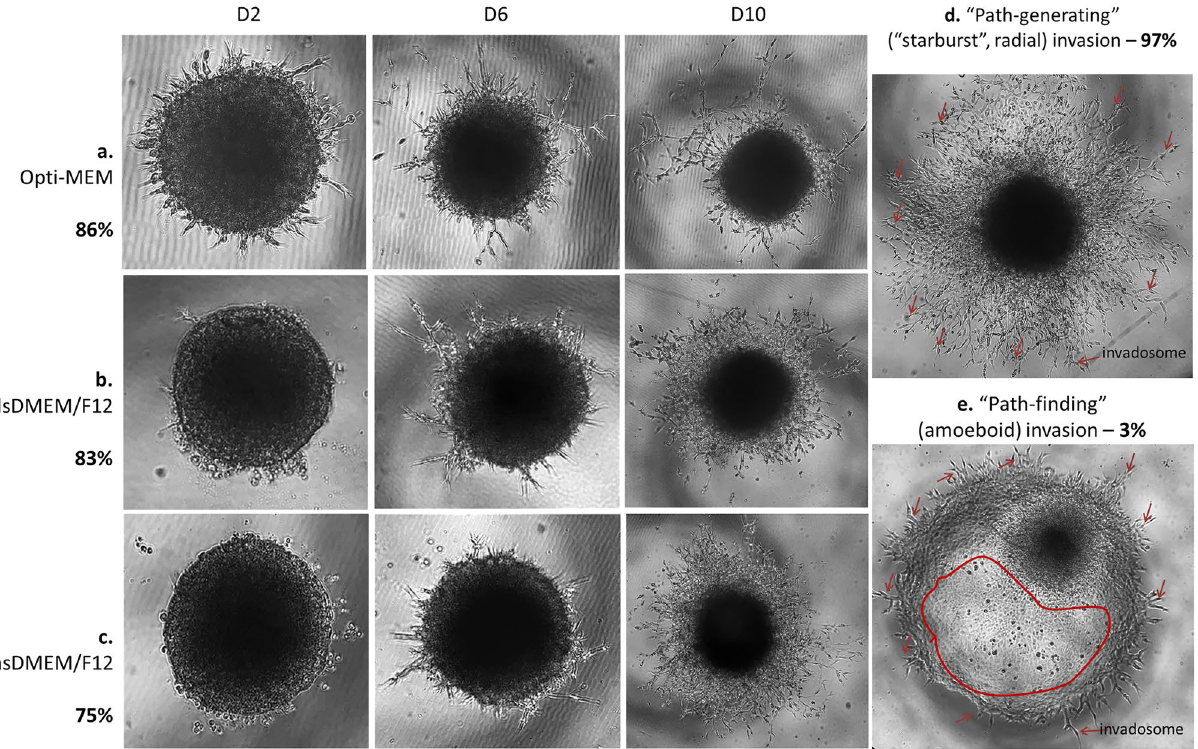
Figure 4. Sw71 spheroids’ propensity for invasion. ( a – c ) Representative triplets of invading Sw71 spheroids. Optimal results were gained in Opti-MEM followed by lsDMEM/F12 and hsDMEM/F12 (86%, 83% and 75% respectively). ( d ) Representative spheroid on D10 in hsDMEM/F12, showing a classical “path-generating” radial invasion pattern, seen in 97% of the cases. ( e ) Representative spheroid on D6 in hsDMEM/F12, showing a non- typical “path-finding” amoeboid invasion (zone marked in red: cells with rounded, deformable morphology squeeze through narrow spaces and smaller pores of the Matrigel). Of note, invading Sw71 spheroid trophoblasts form invadosomes (orange arrows) for the proteolysis-dependent ECM degradation which are numerous and well-developed in radial invasion ( d ) and only a few in the amoeboid invasion ( e ). Imaging: Echo Revolve microscope, Echo, San Diego, CA, USA, magnification 4× ± digital zoom. Seven independent experiments were